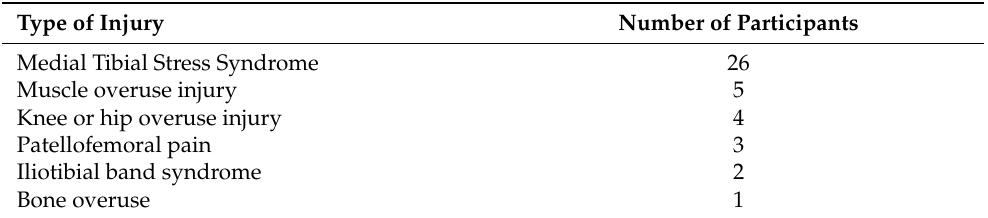
Table 2. Type and incidence of lower-limb overuse injuries diagnosed during the six-month follow- up period.